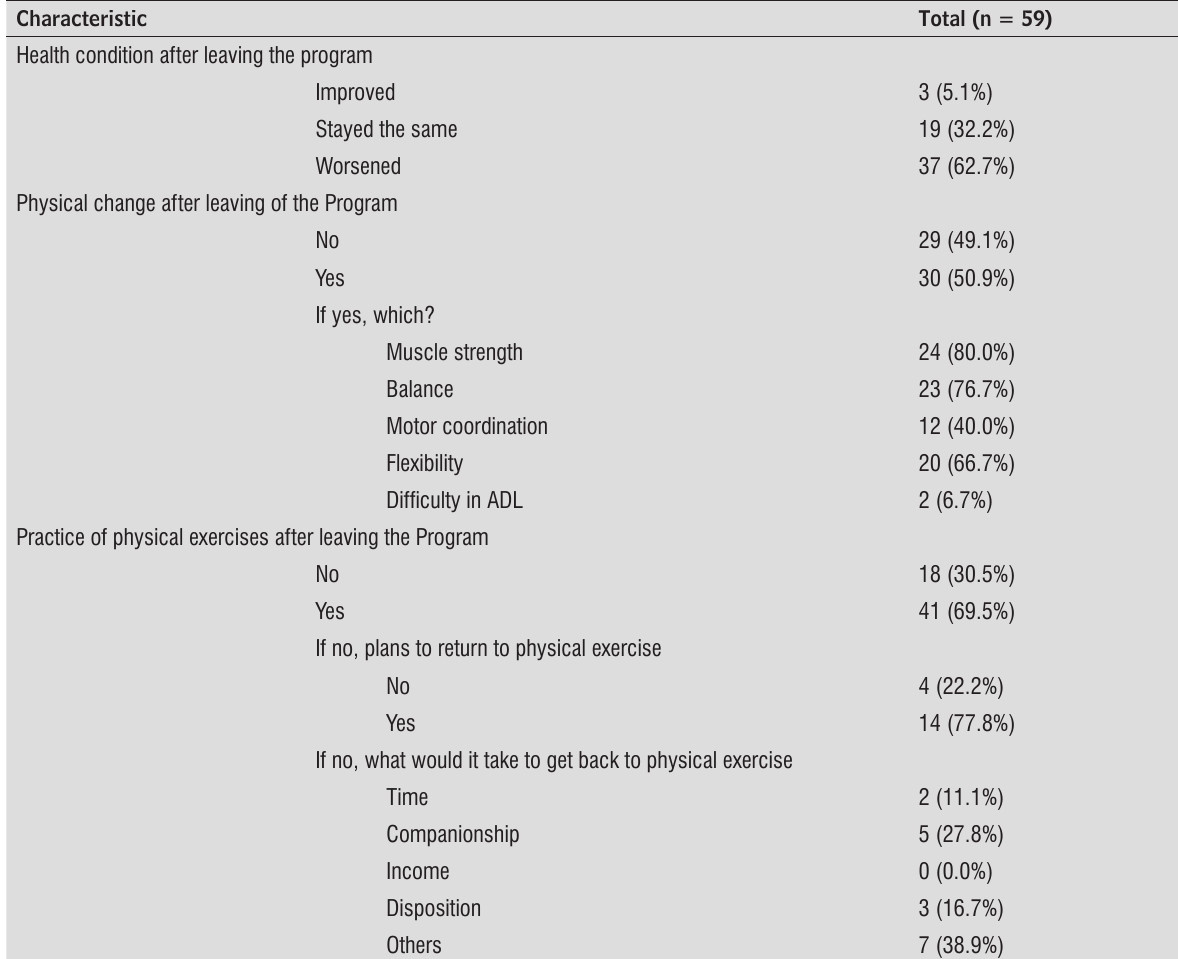
Table 1 - Characteristics of health condition, physical changes, and the practice of physical exercises after abandoning the Geriatric Revitalization